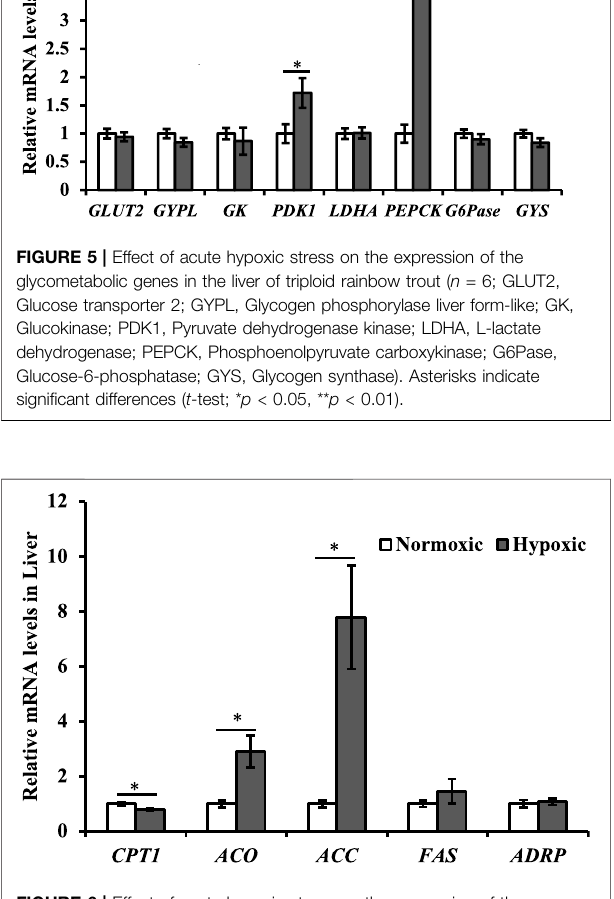
FIGURE 6 | Effect of acute hypoxic stress on the expression of the lipometabolic genes in the liver of triploid rainbow trout ( n = 6; CPT1, carnitine palmitoyl transferase 1; ACO, acetyl-CoA oxidase; ACC, acetyl-CoA carboxylase; FAS, fatty acid synthase; ADRP, adipose differentiation- related protein). Asterisks indicate signi fi cant differences ( t -test; * p < 0.05, ** p < 0.01).